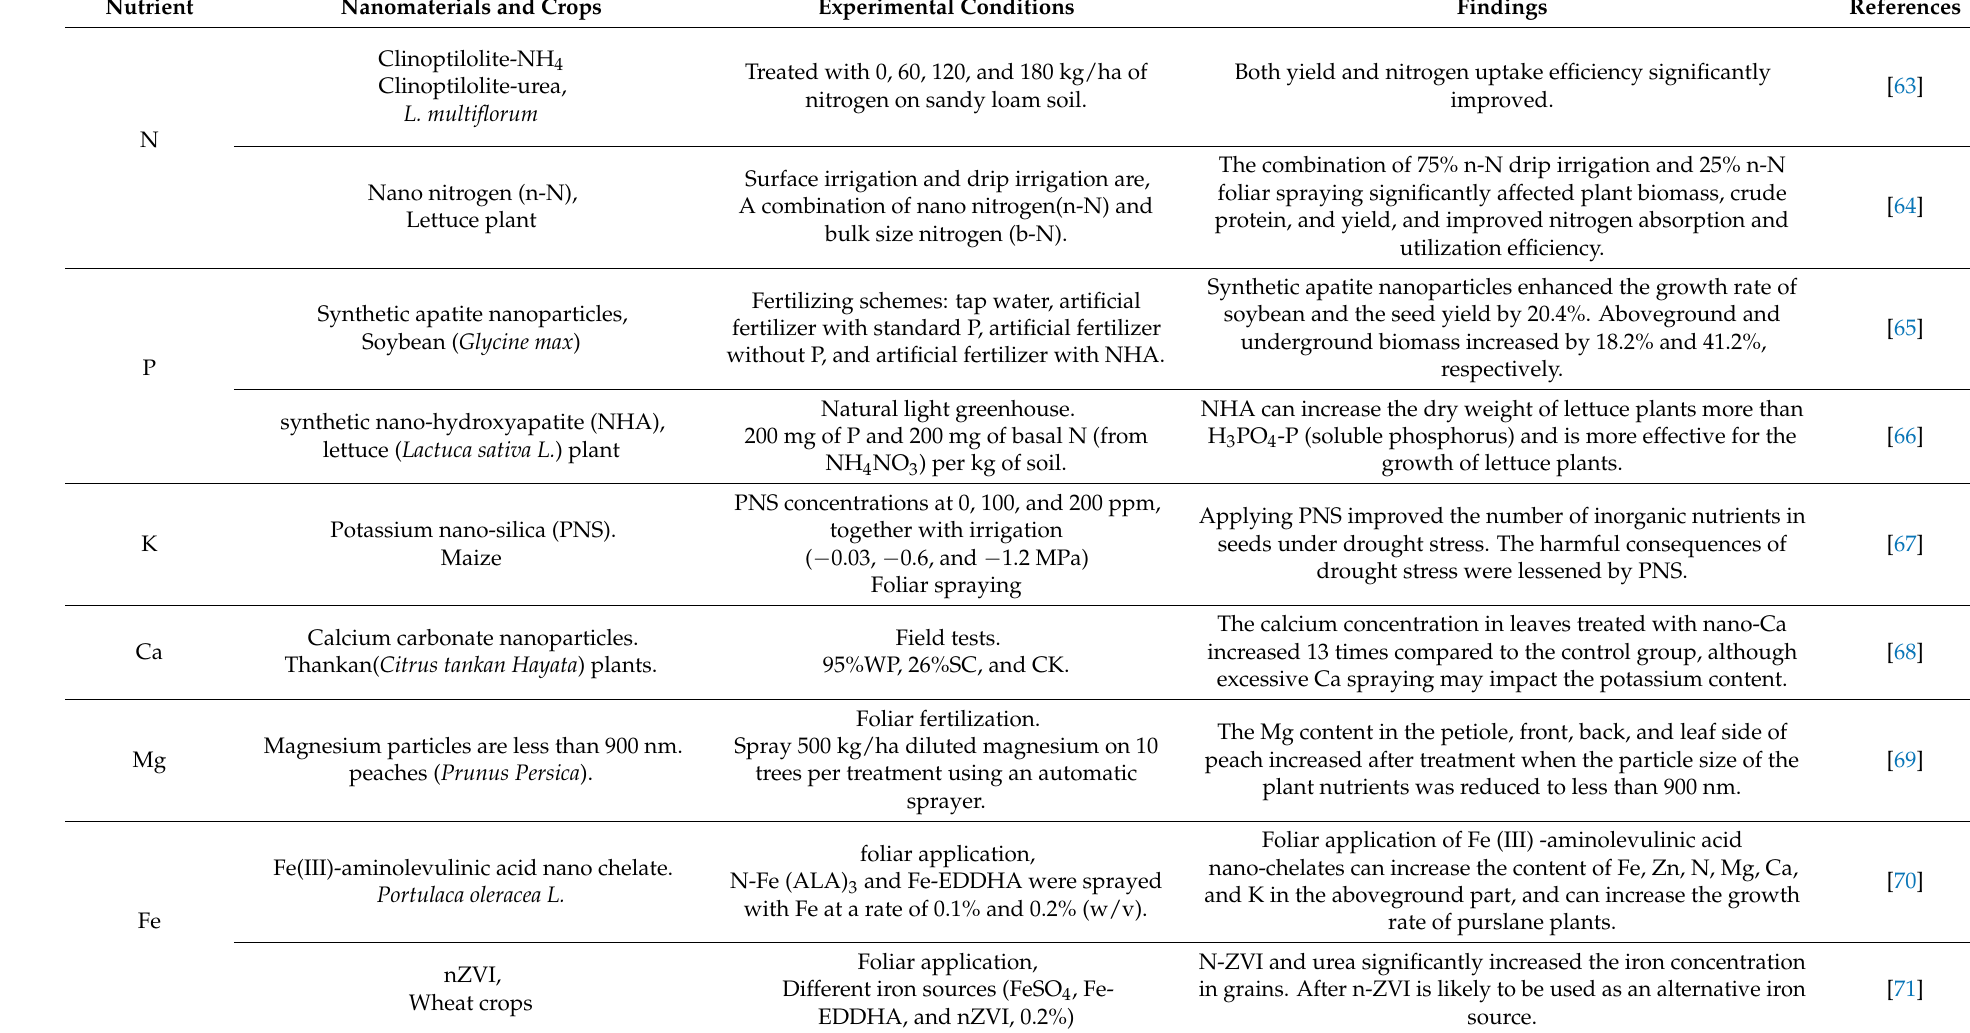
Table 1. Nanomaterials as plants supplement the infinite nutrients and enhance plant growth and